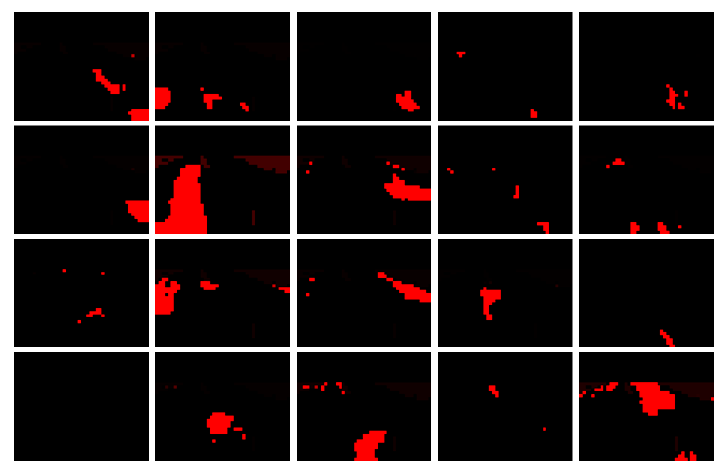
Figure 10. Twenty latent motion regions discovered by RTM-HSVG.